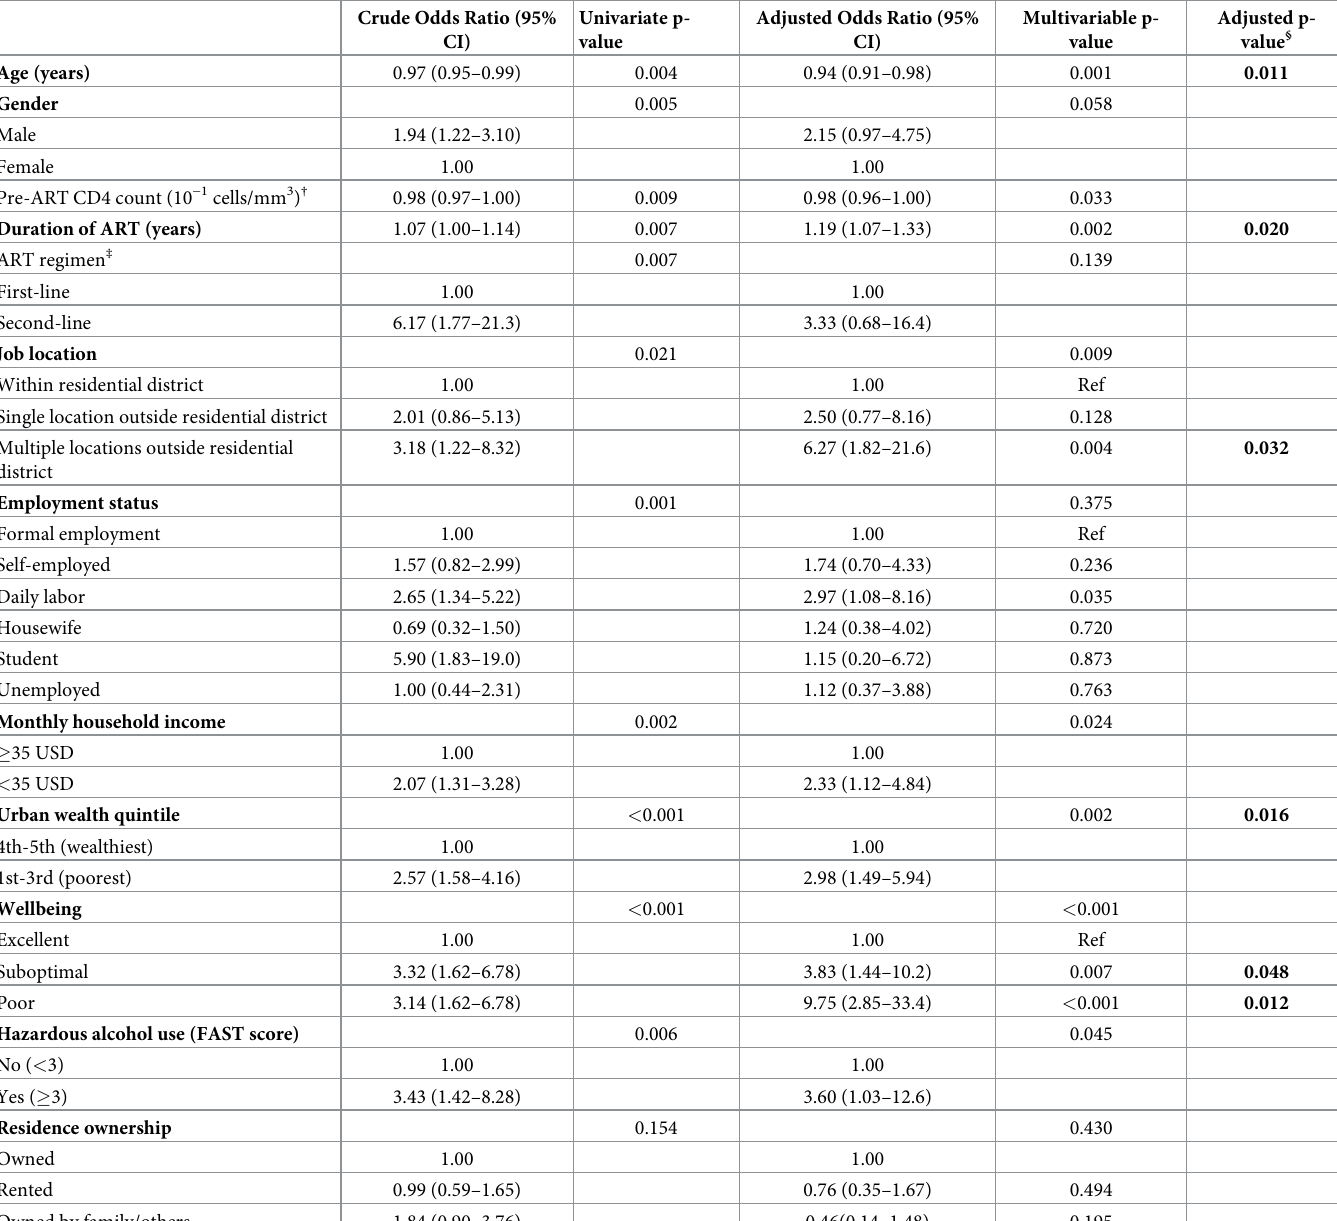
Table 4. Factors associated with lack of viral suppression among urban study participants, Adama Region,